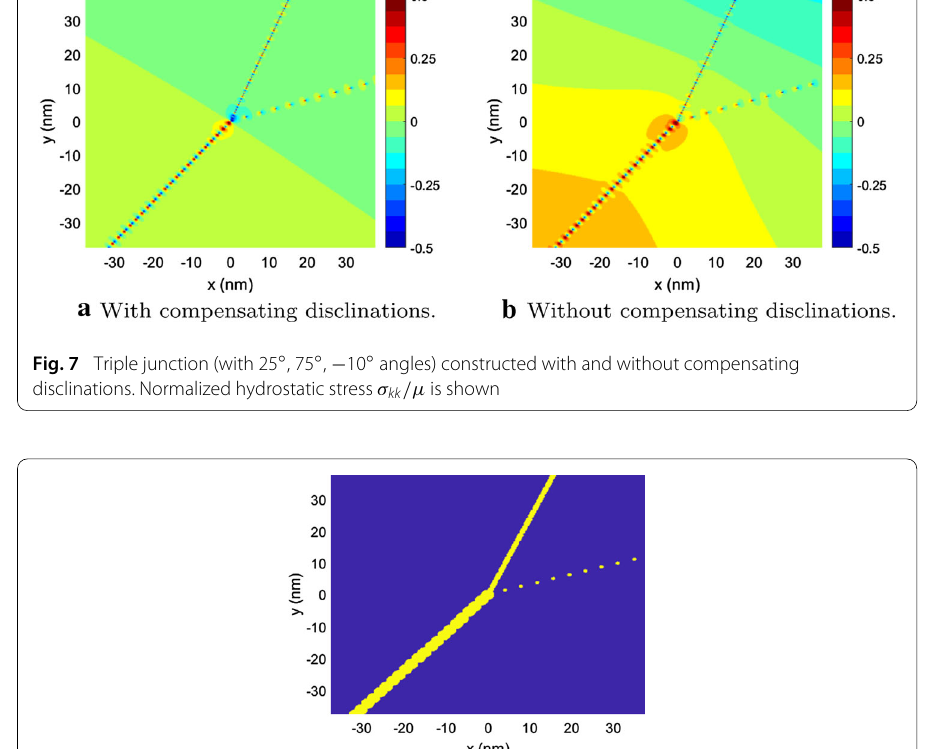
reference x-axis is assumed to be zero, i.e., the x-axis is aligned with the structure of the first grain. The remaining parameters are computed via Eqs. (13)–(15). The